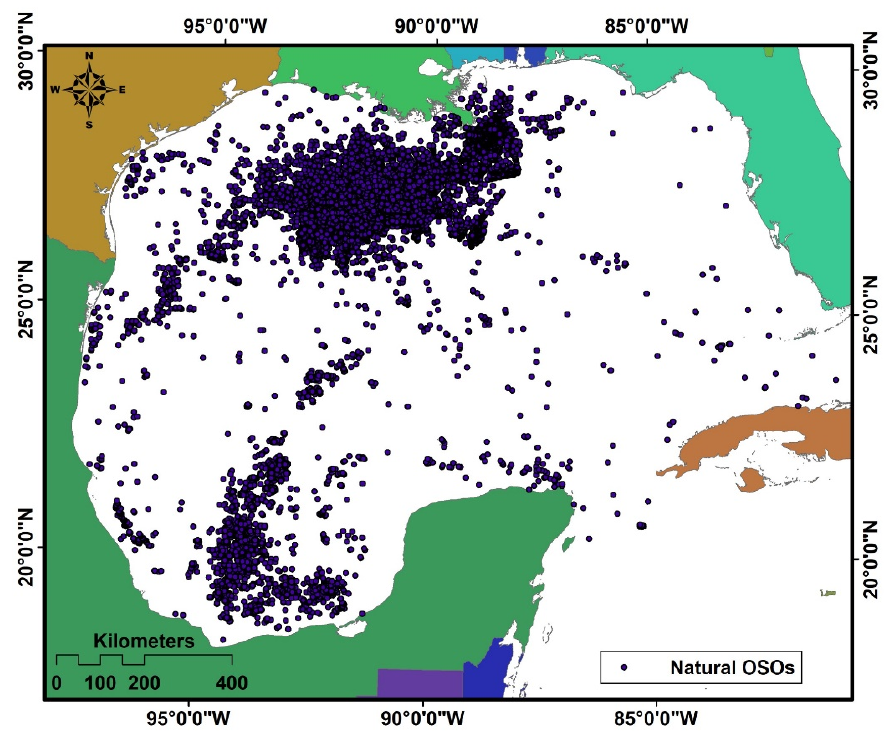
Figure 3. Locations of interpreted natural OSOs in the Gulf of Mexico. Table 2. Data acquired from vendors and MacDonald et al. [11] , including all classifications.